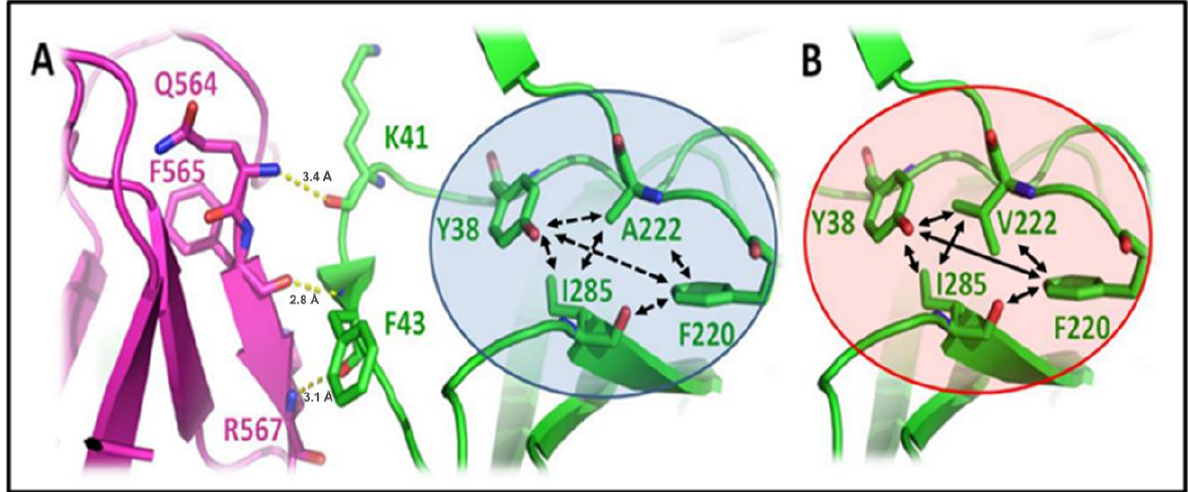
Figure 3. The wild-type A222 in the spike glycoprotein mutates to V222, shown in the A222V mutation. The green illustration represents the NTD, with the residues residing close to the RBD in magenta. ( A ) Neighboring hydrophobic residues surround the wild-type A222 in the spike glycoprotein: Y38, I285, and F220. The representation is shown in the blue circle; ( B ) The mutated V222 in the S protein is surrounded by hydrophobic residues; Y38, I285, and F220 make a comparatively strong hydrophobic core (shown in the red circle). The dotted/straight (double-headed arrow) illustrates the hydrophobic interaction. The length between residues is shown in units of Angstrom (Å).